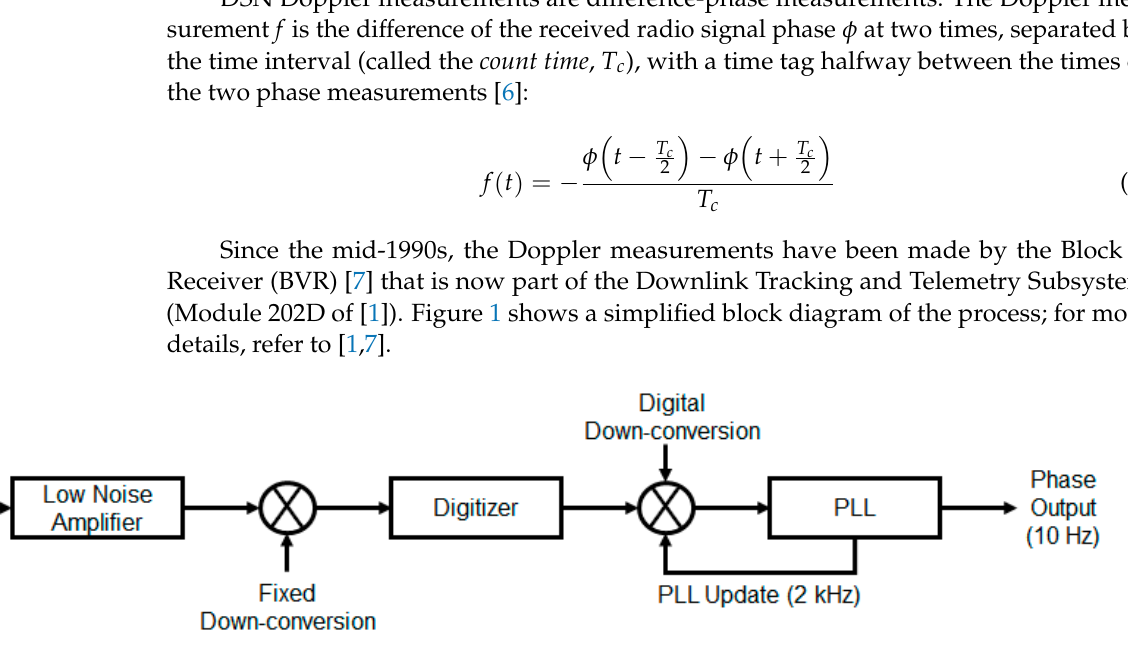
Figure 1. Simplified block of the closed-loop Doppler measurement process.